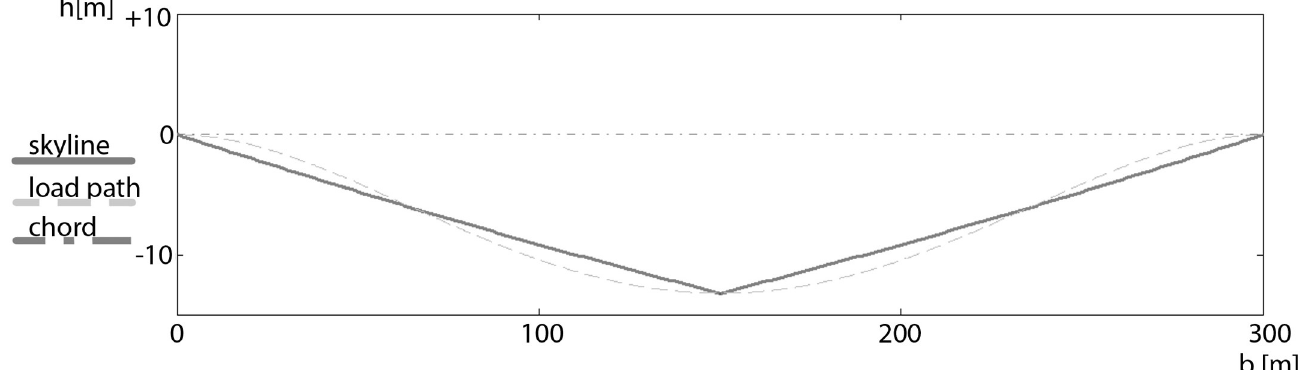
Fig 4. Sag with carriage at midspan position in a flat single-span configuration.